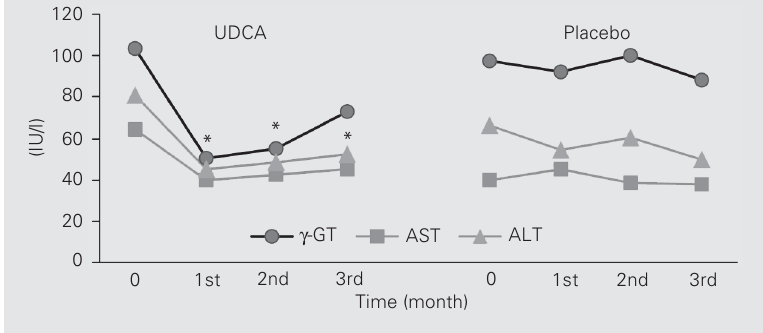
Figure 3. γ -Glutamyltransferase ( γ -GT), aspartate (AST) and alanine (ALT) aminotransferase values of the ursodeoxycholic acid (UDCA)-treated and untreated (placebo) patients deter- mined at the beginning and after the first, second and third month of the experiment. Data are reported for 14 patients in each group. Error bars were omitted to improve the understanding of the figure. *P < 0.05 compared to the beginning of the experiment (Bonferroni